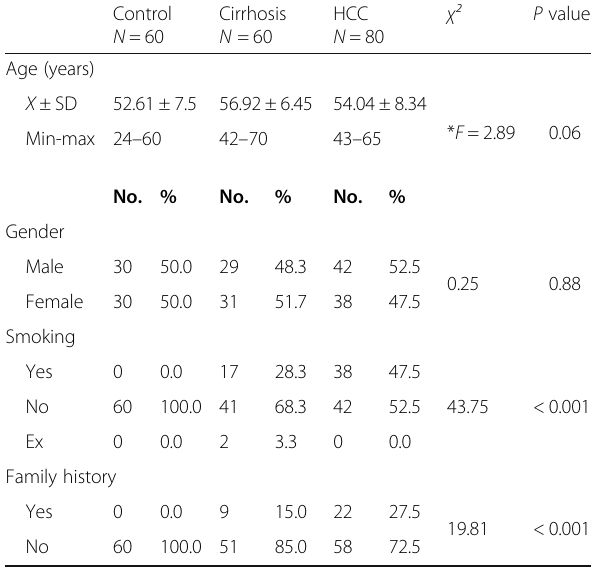
Table 1 Socio-demographic data of the studied groups Control N =